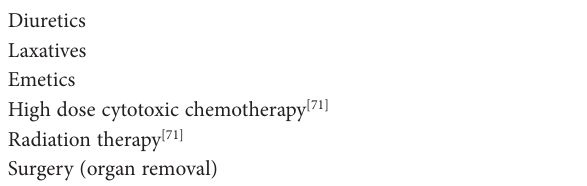
Table 4. Drugs excreting entropy as waste